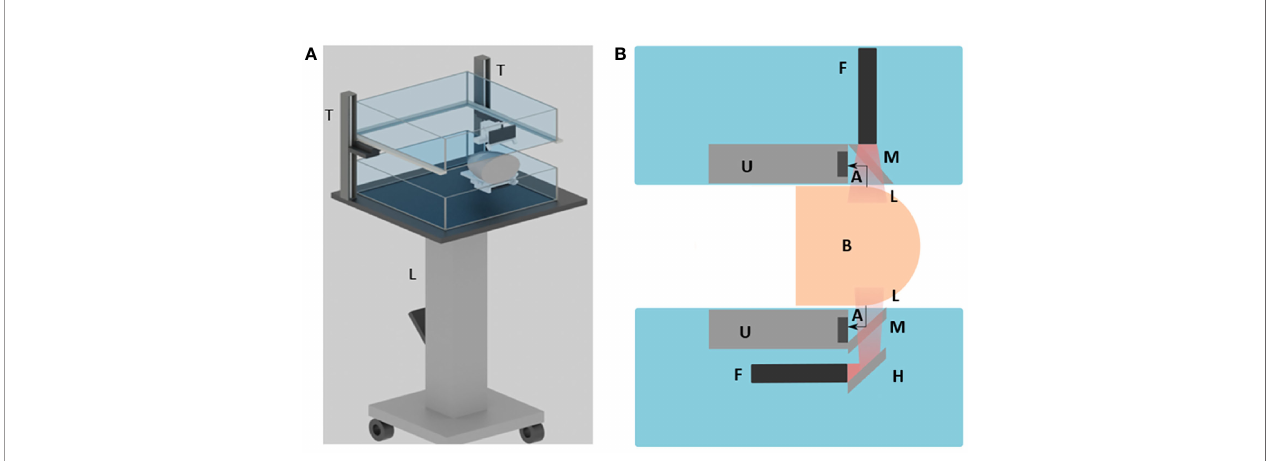
FIGURE 1 | Overview of the DSM-2 system setup. (A) 3D schematic drawing of the system. L, the lift table; T, translation stages. (B) Cross-sectional view of the system. A, acoustic wave; F, fi ber bundle; H, hot mirror; L, light beam; M, cold mirror; and U, the ultrasound transducer array.